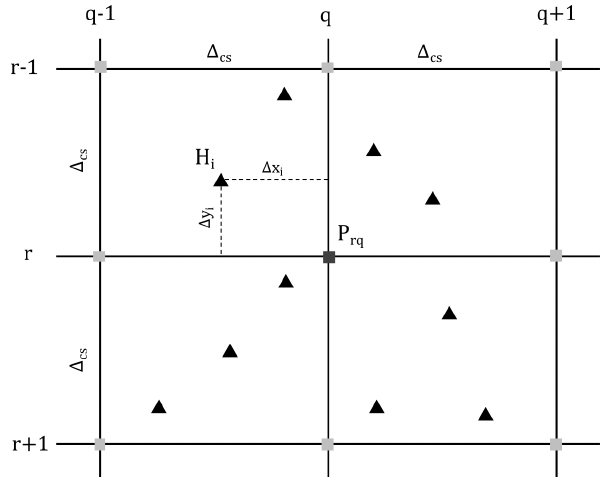
Figure 5. Two-dimensional stencil, used to summarise the bilinear interpolation of interface positions within cones ( H i , (cid:78) ) to a fixed grid ( P rq , (cid:4) ) with a user-defined cell size (cid:49) cs . Every interface po- sition within a ± (cid:49) cs interval contributes to the grid height P rq